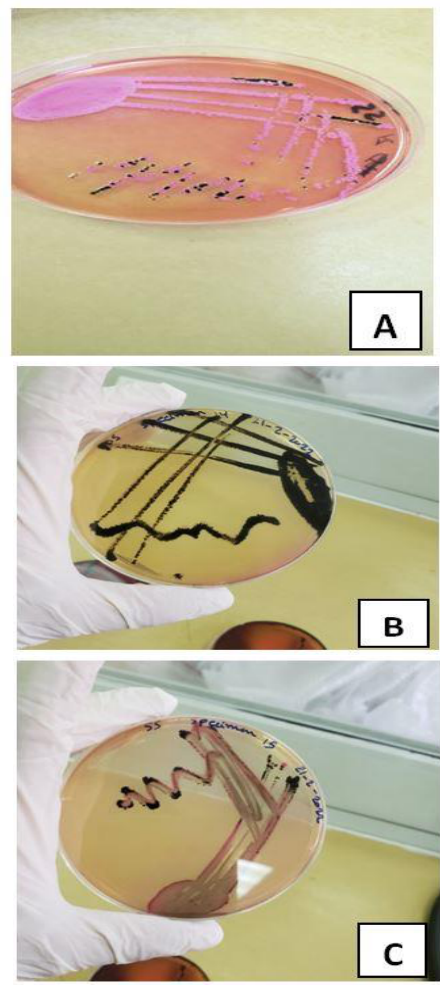
Fig.2 (A, B,C): Salmonella spp. on S.S agar at 37°C for 24